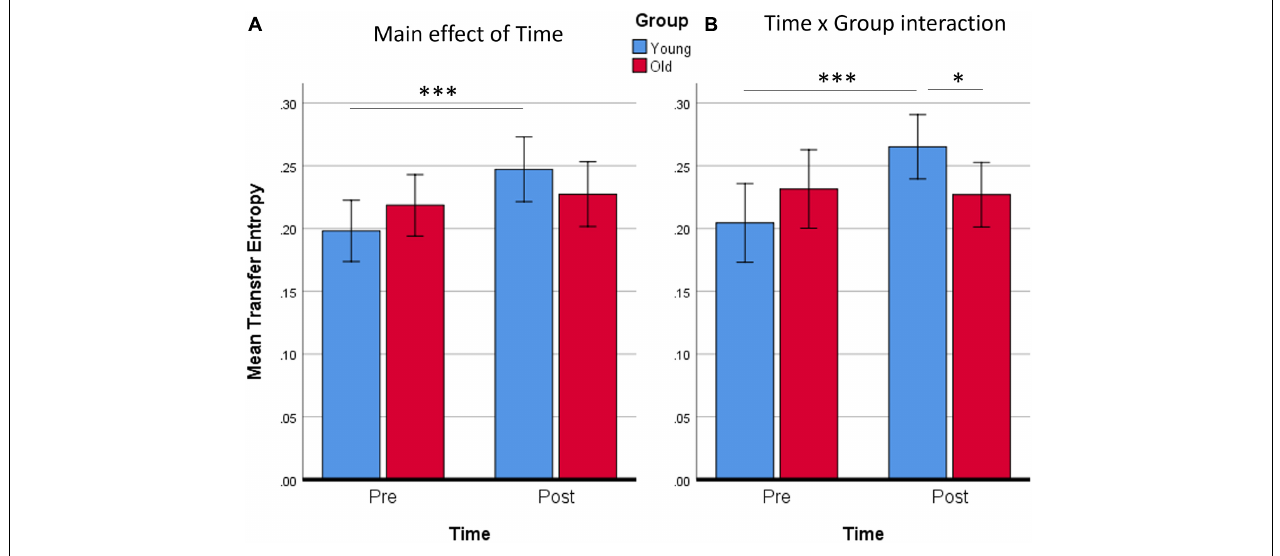
FIGURE 6 | Averaged Transfer Entropy of all supra-threshold connections of the network for the main effect of Time (A) , or for the Time × Group interaction (B) . It is evident from both contrasts that only the Young group increased Transfer Entropy. ∗ p < 0.05; ∗∗∗ p ≤ 0.001. Error bars show 95%